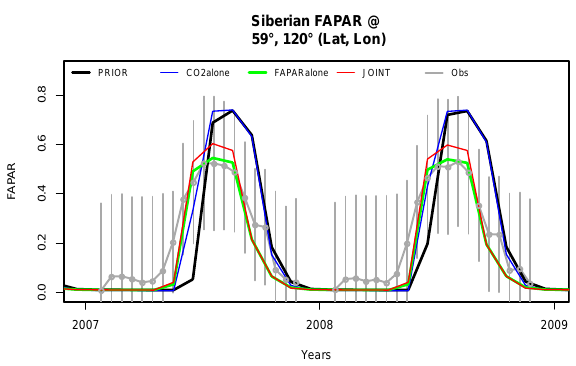
Figure 2. Example time series of FAPAR for an East Siberian pixel dominated by the CD-PFT to demonstrate the improvement in the timing of the phenology due to the data assimilation. TIP-FAPAR observations are given with their mean (dots) and 1 σ uncertainties (vertical